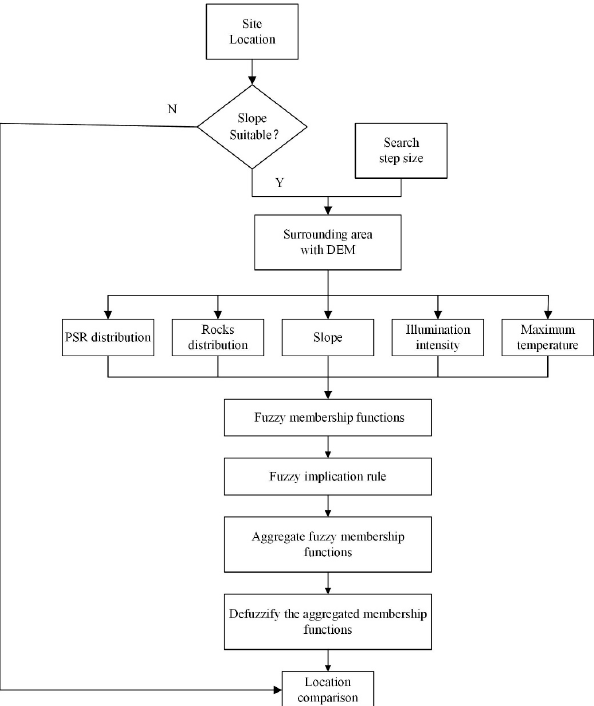
Figure 2. The flowchart of the lunar south pole landing site selection